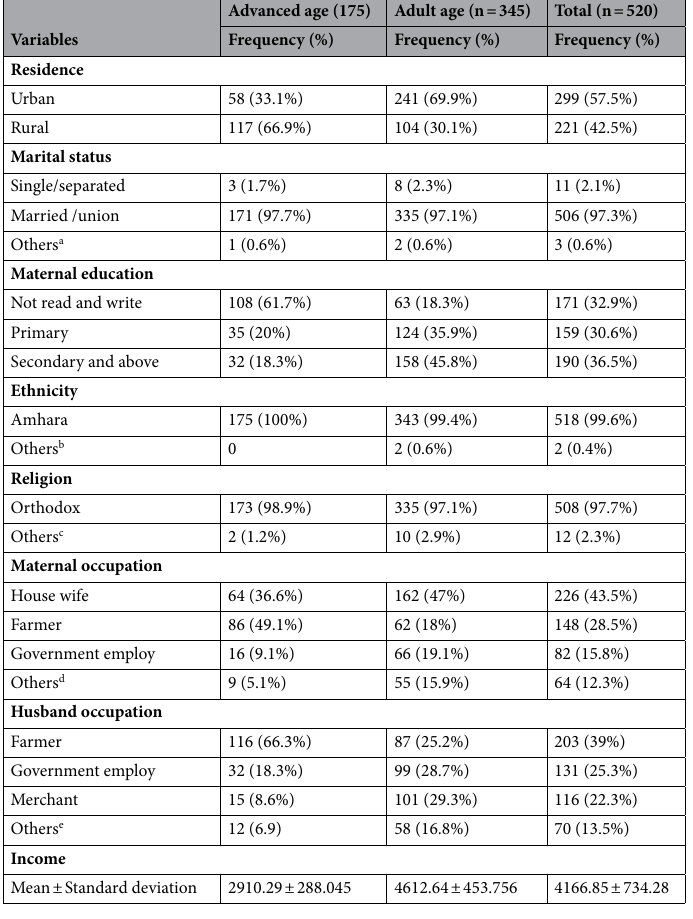
Table 1. Socio-demographic and life style characteristics of mothers who gave birth in Awi Zone Public Hospitals, Ethiopia, 2020. a Divorced and widowed. b Oromo and Benishangul Gumz. c Muslim and